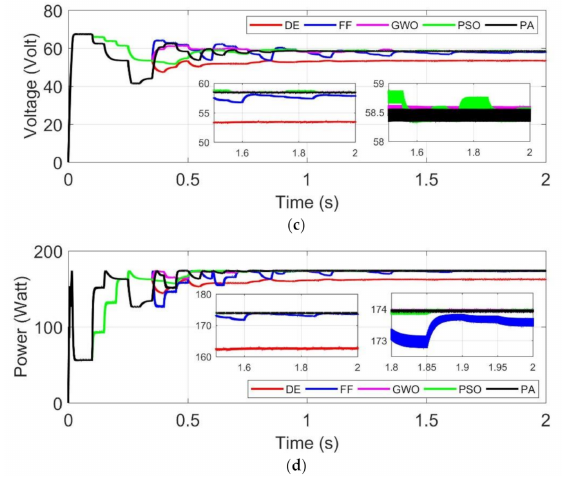
Figure 12. Test 4 ( a ) Initial particles ( b ) Duty cycle (%) ( c ) PV voltage (V) ( d ) PV power (W).